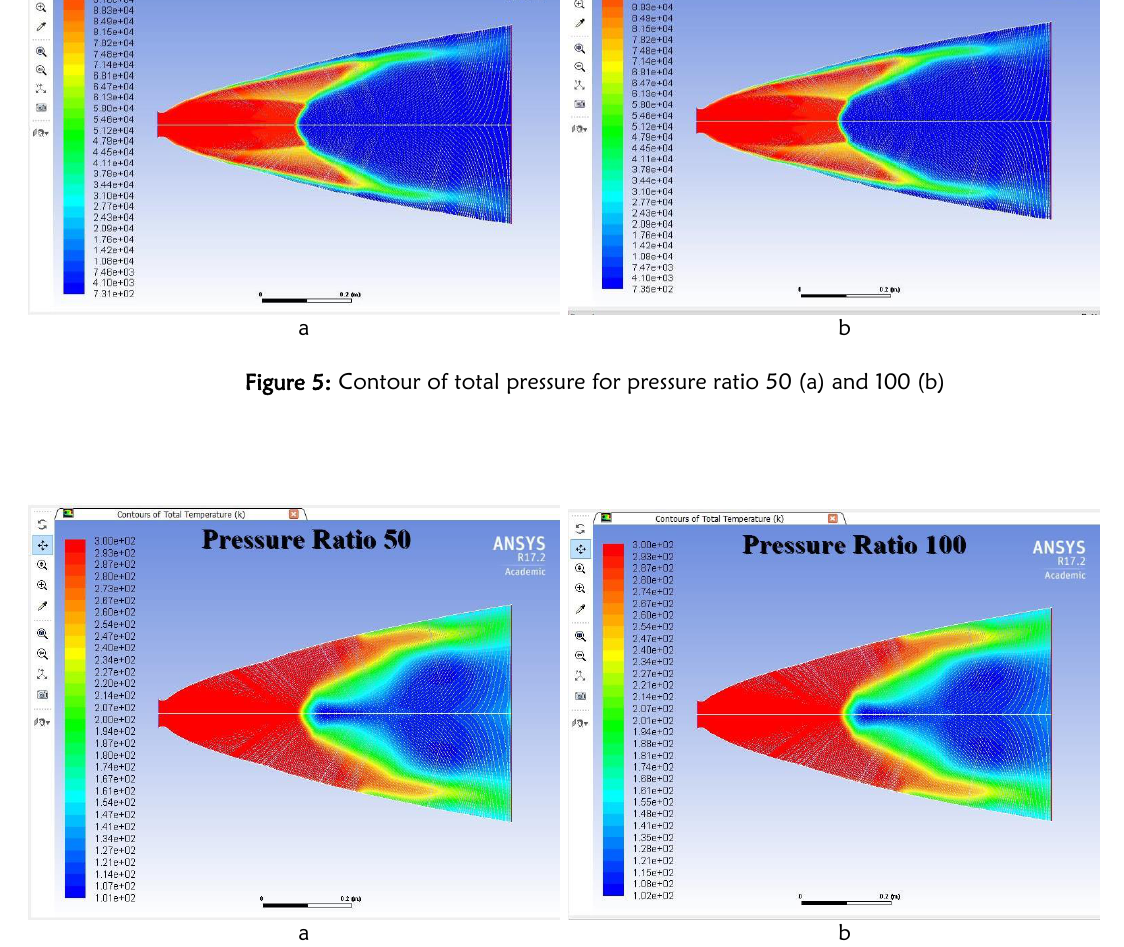
Figure 6: Contour of total temperature for pressure ratio 50 (a) and 100 (b)